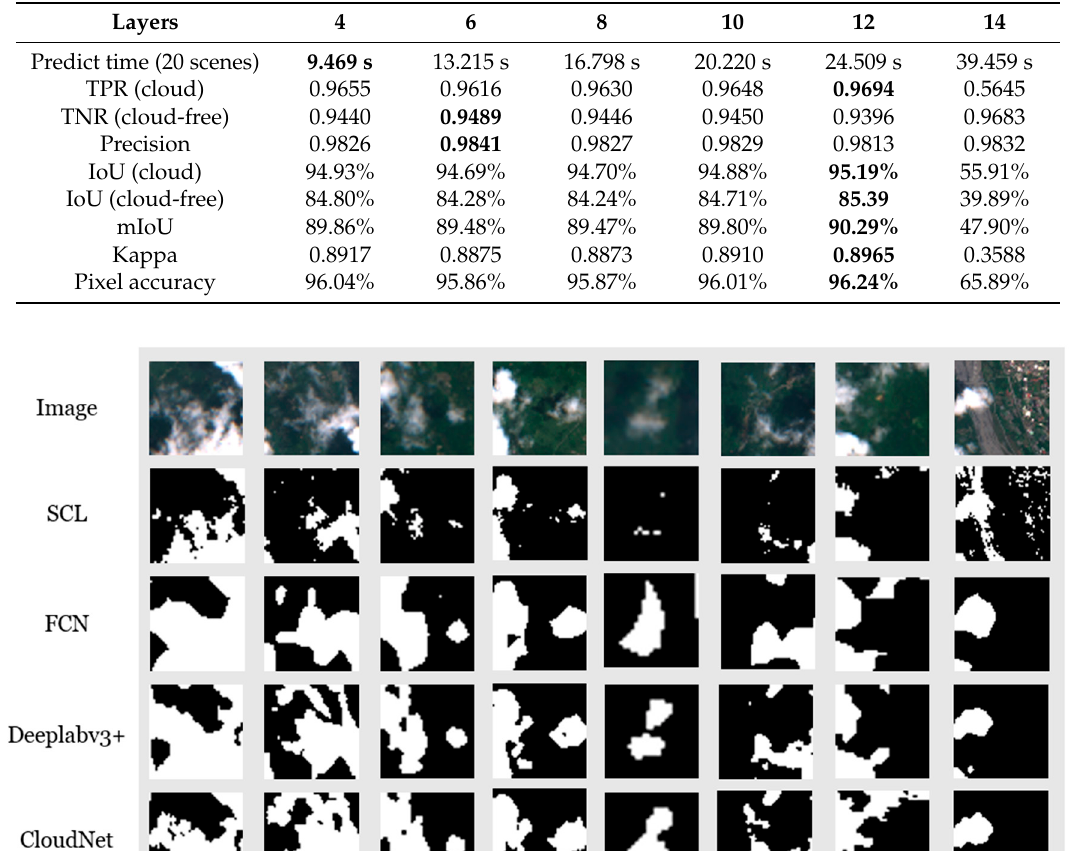
Table 2. Optimization of the number of layers to be used by CloudNet.